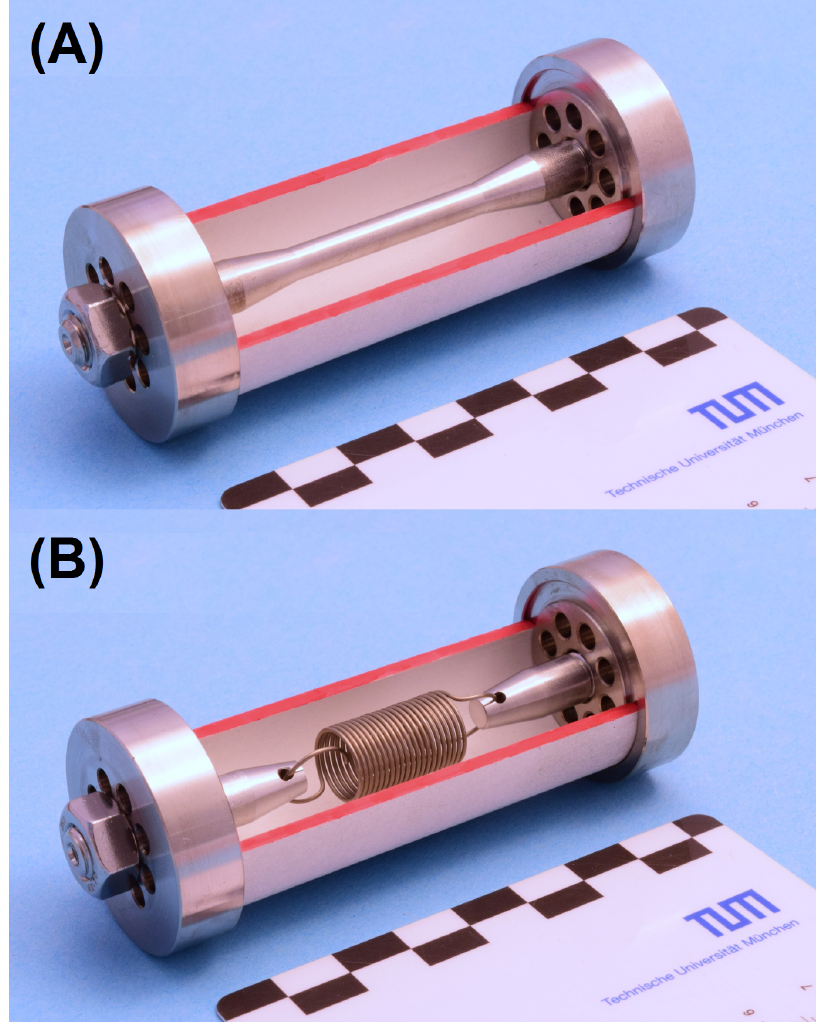
Figure 1. Cutaway model of the hollow cylinder stress cells used in this study. ( A ) Stress cell with constraint by a central steel rod. ( B ) Stress cell with virtually no constraint by using a steel spring with a low spring constant. Table 1. Chemical composition (ICP-OES) and mineralogical composition (XRD) of the binders used in this study